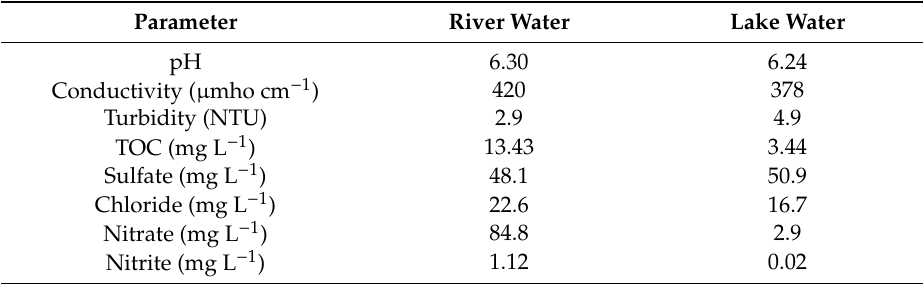
Figure 16. Photocatalytic degradation rates of pirimicarb in deionized water and natural water samples. Experimental conditions: 1.0 wt% Pt / AgInS 2 concentration 1.0 g L − 1 . Error bars represent the standard deviations of duplicate runs. Table 5. Characteristics of the real water sample .